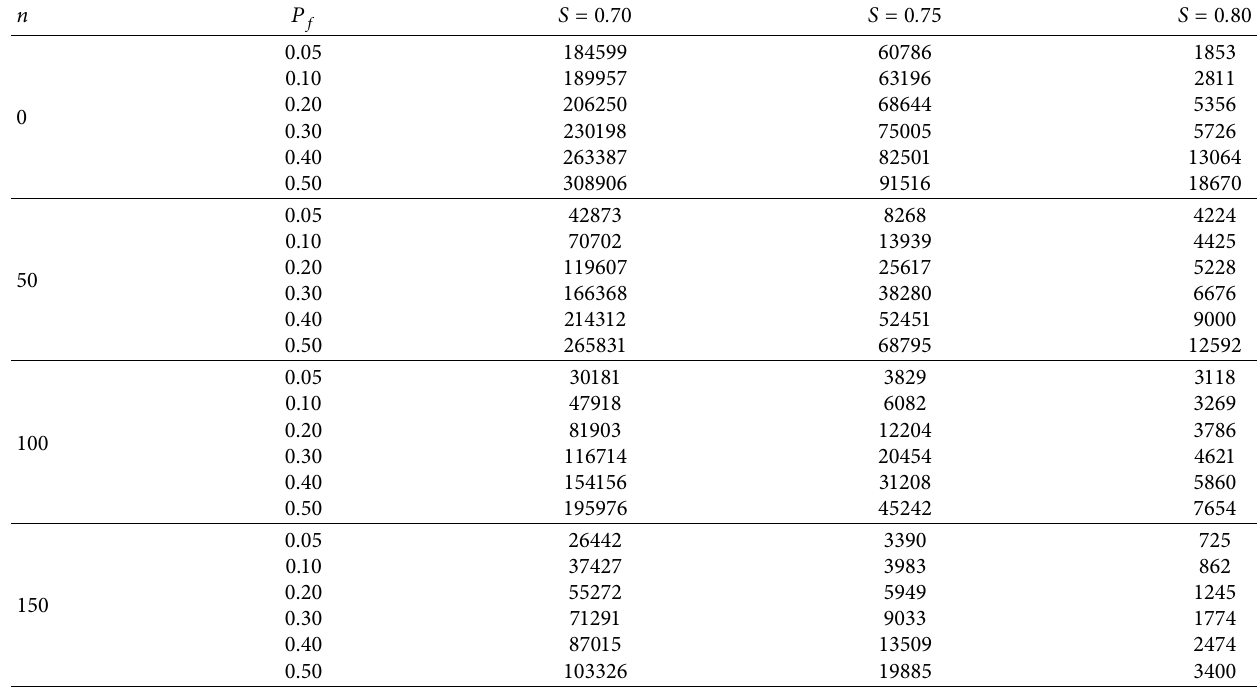
Table 13: Flexural fatigue life ( N p ) of AASC for various failure